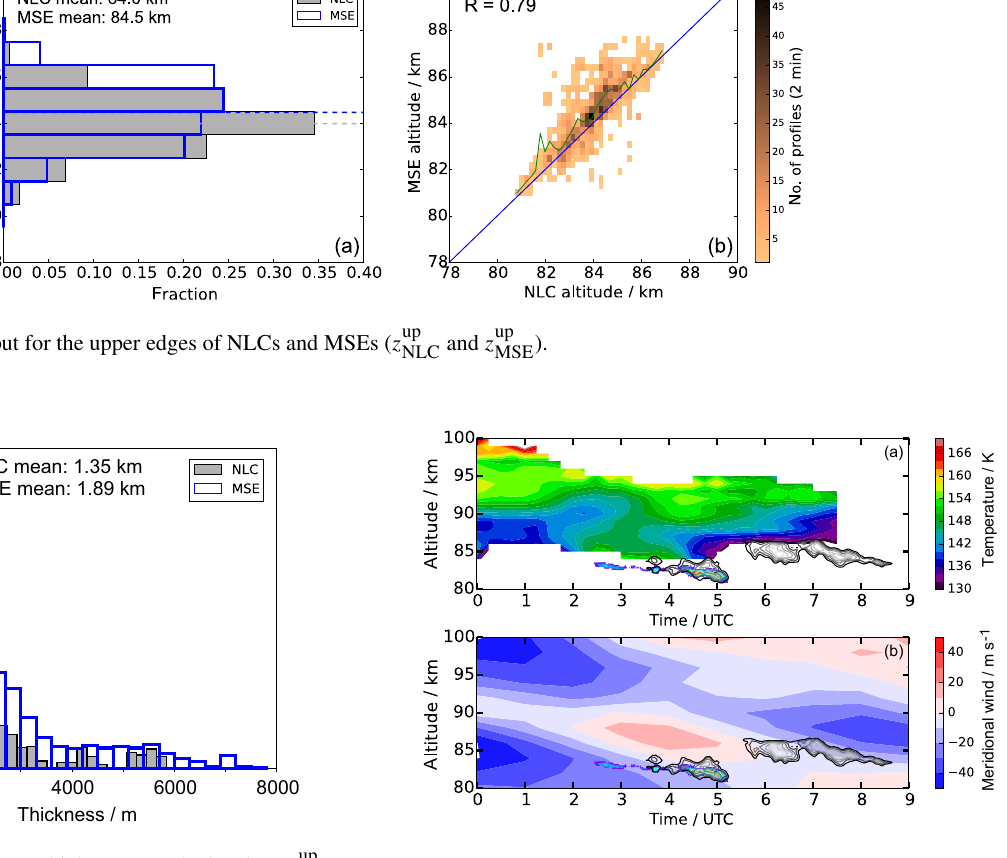
− Figure 6. Histogram of layer thicknesses, calculated as z up Figure 7. Temperature (a) and meridional wind (b) above Küh- NLC − z low z low for NLCs (grey, filled) and z up for MSE (blue, lungsborn during 26 and 27 June 2011. The MSE data are embed- NLC MSE MSE open). The relative occurrence ( O ) is normalized such that all bins ded in both panels for illustration as open grey contours and the times the bin width ( (cid:49) ) sum to 1; i.e., P (O · (cid:49)) = 1. Bin widths NLC data in colored filled contours. Cloud 1: 02:30–05:15UTC, are 195m for NLCs and 300m for MSEs. Cloud 2: